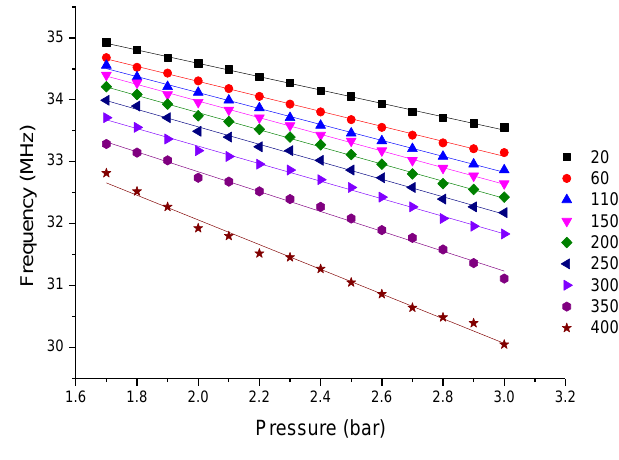
Figure 6. Extracted frequency versus pressure at different